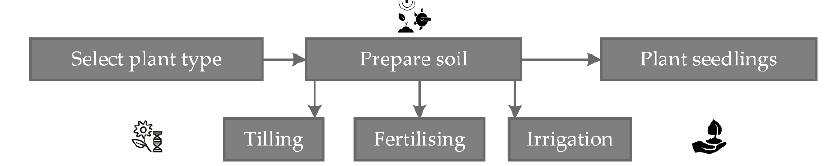
Figure 2. Conventional steps in horticulture.